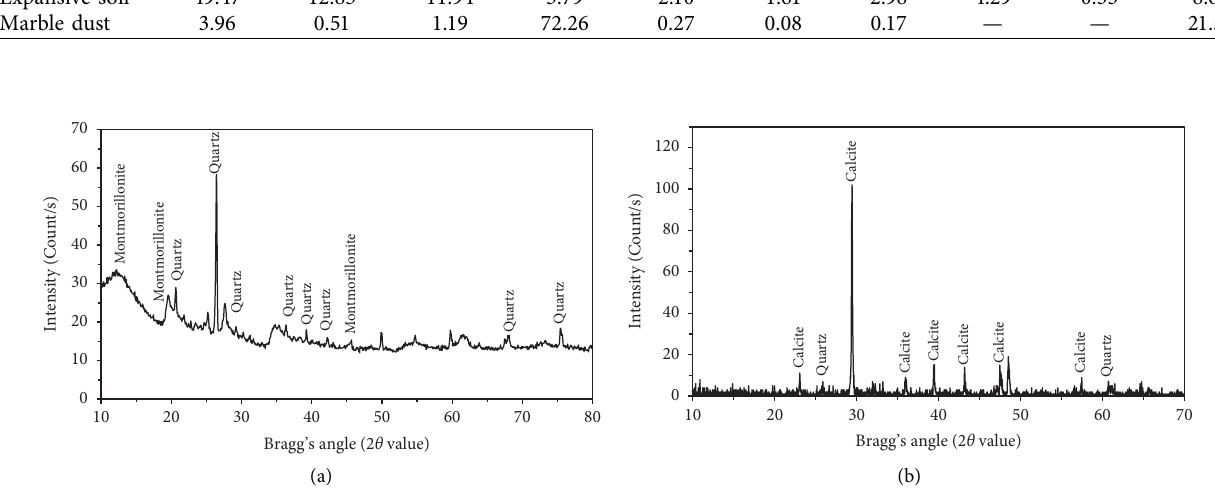
Figure 4: Mineralogical composition. (a) Expansive soil. (b) Marble